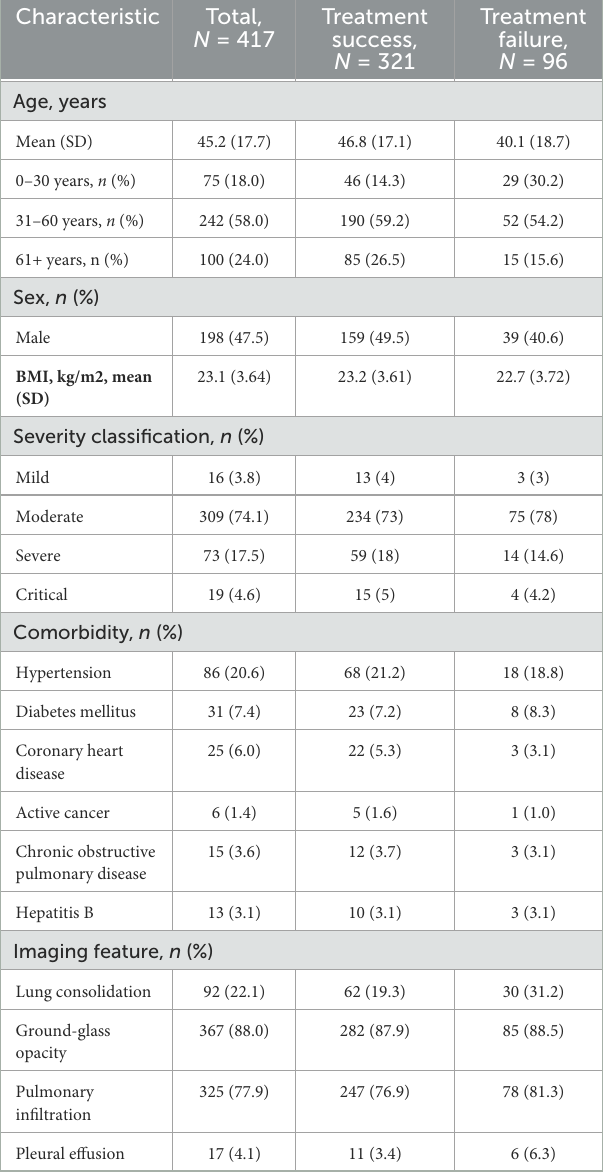
TABLE 1 Summary of demographics and baseline characteristics for all COVID-19 patients (measured at initial admission to hospital), treatment success group and treatment failure